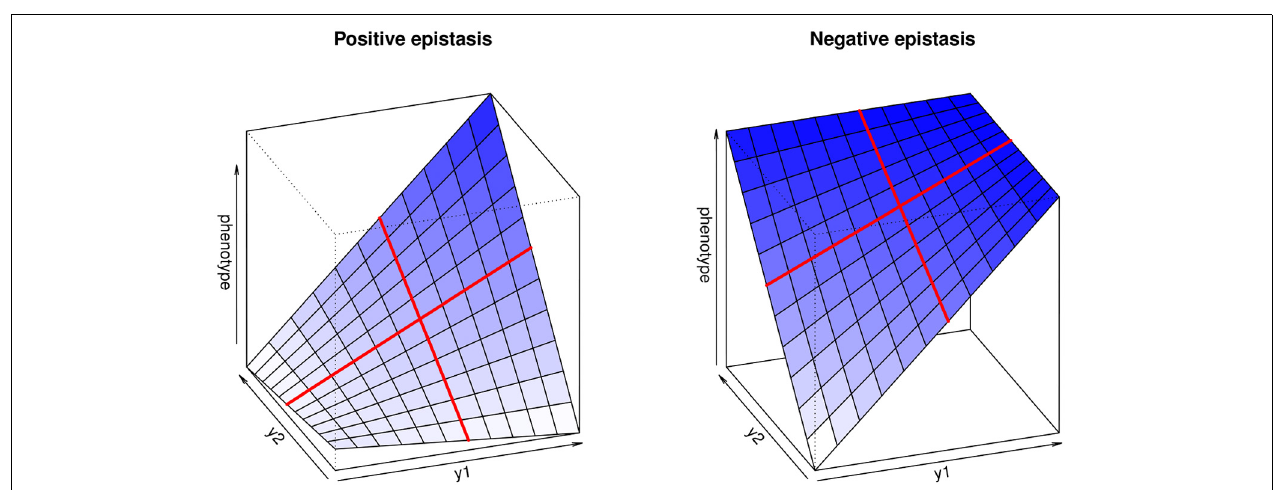
highlight the multilinearity of the model: if the genetic background is kept constant, phenotype change depends linearly on the genotype at each